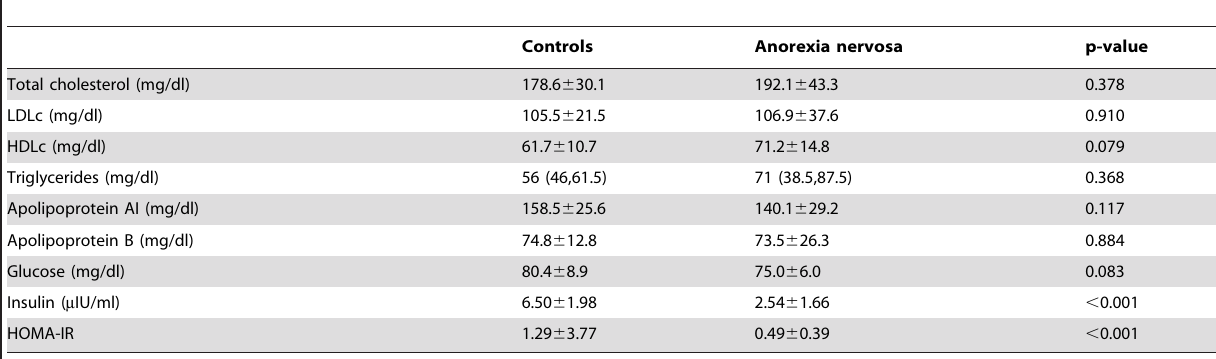
Table 2. Endocrine parameters in anorexia nervosa (AN) patients and healthy control